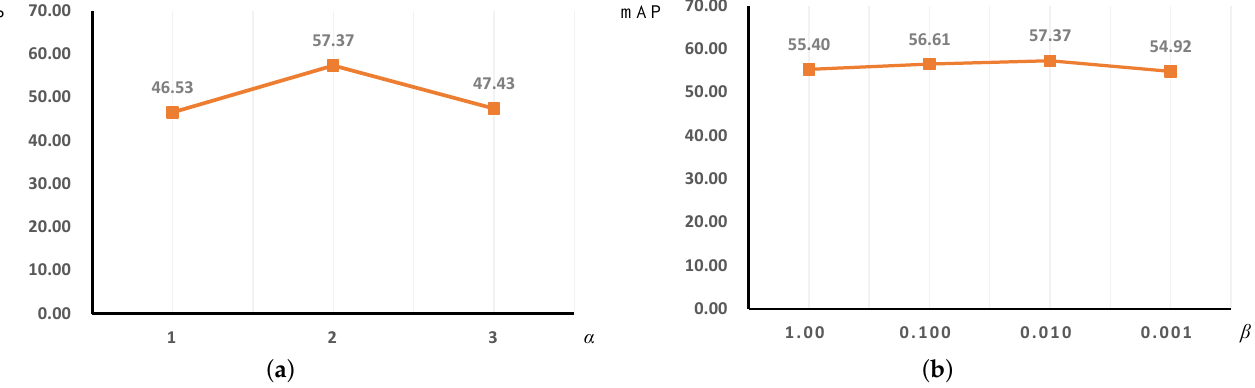
Figure 8. Analysis of trade-off parameters α and β . ( a ) The effect of parameter α on detection performance when β is fixed at 0.01. ( b ) The effect of parameter β on detection performance when α is fixed at 2.